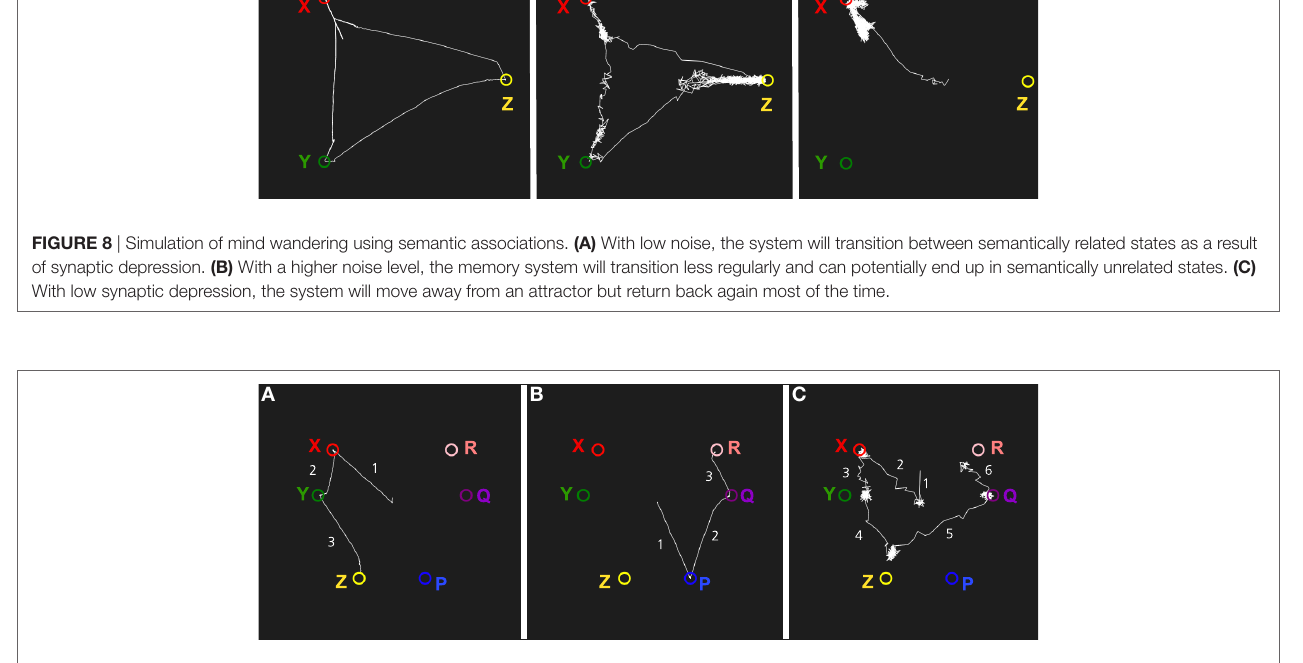
FigUre 9 | Simulation of episodic recall. The three graphs show transitions between the attractors of the network. (a) Recall of the episode X, Y, Z cued by an input X. (B) Recall of the episode P, Q, R cued by P. (c) A higher noise level produces a novel imagined episode that is a combination of two experienced episodes: X, Y, Z, Q, R.